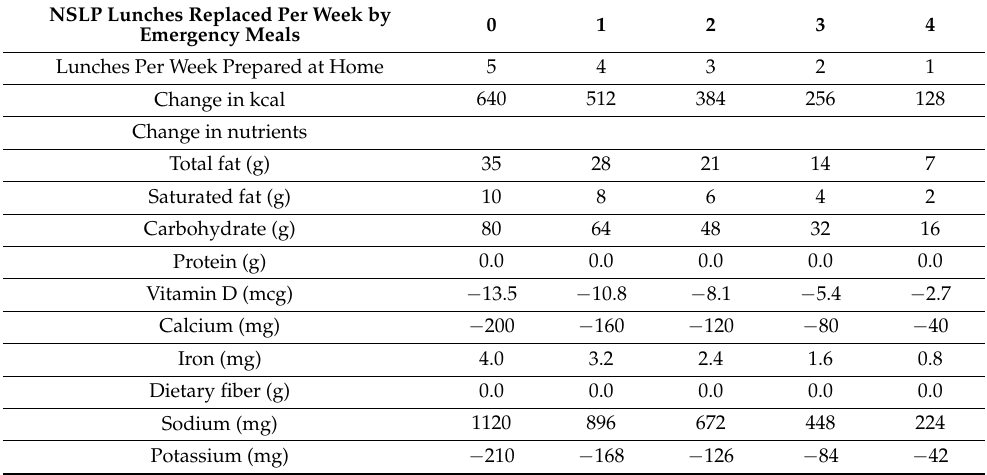
Table 2. Estimated per-student total weekly change in lunchtime calories and nutrients consumed, assuming 0–4 lunches are replaced through COVID emergency meal